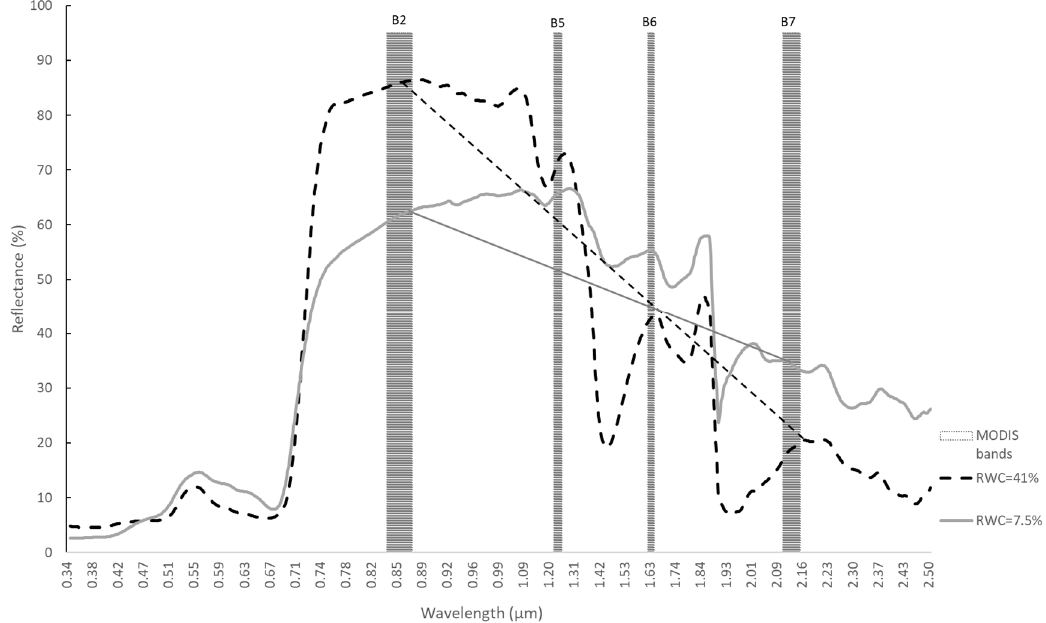
Figure 1. Spectral reflectance measured in the laboratory using spectrometer SVC HR-1024i from soybean leaves with two different values of relative water content. Straight lines show the difference between NIR and SWIR reflectances (in this case, bands centered at 0.86 and 2.13 μ m, respectively), which rise with increasing leaf water content. As an example, bands of MODIS sensor in NIR and SWIR (bands 2, 5, 6, and 7) are included.